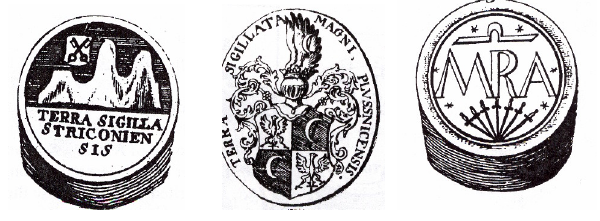
Figure 1: Terra Sigillata ; Adapted from Reinbacher (2003).